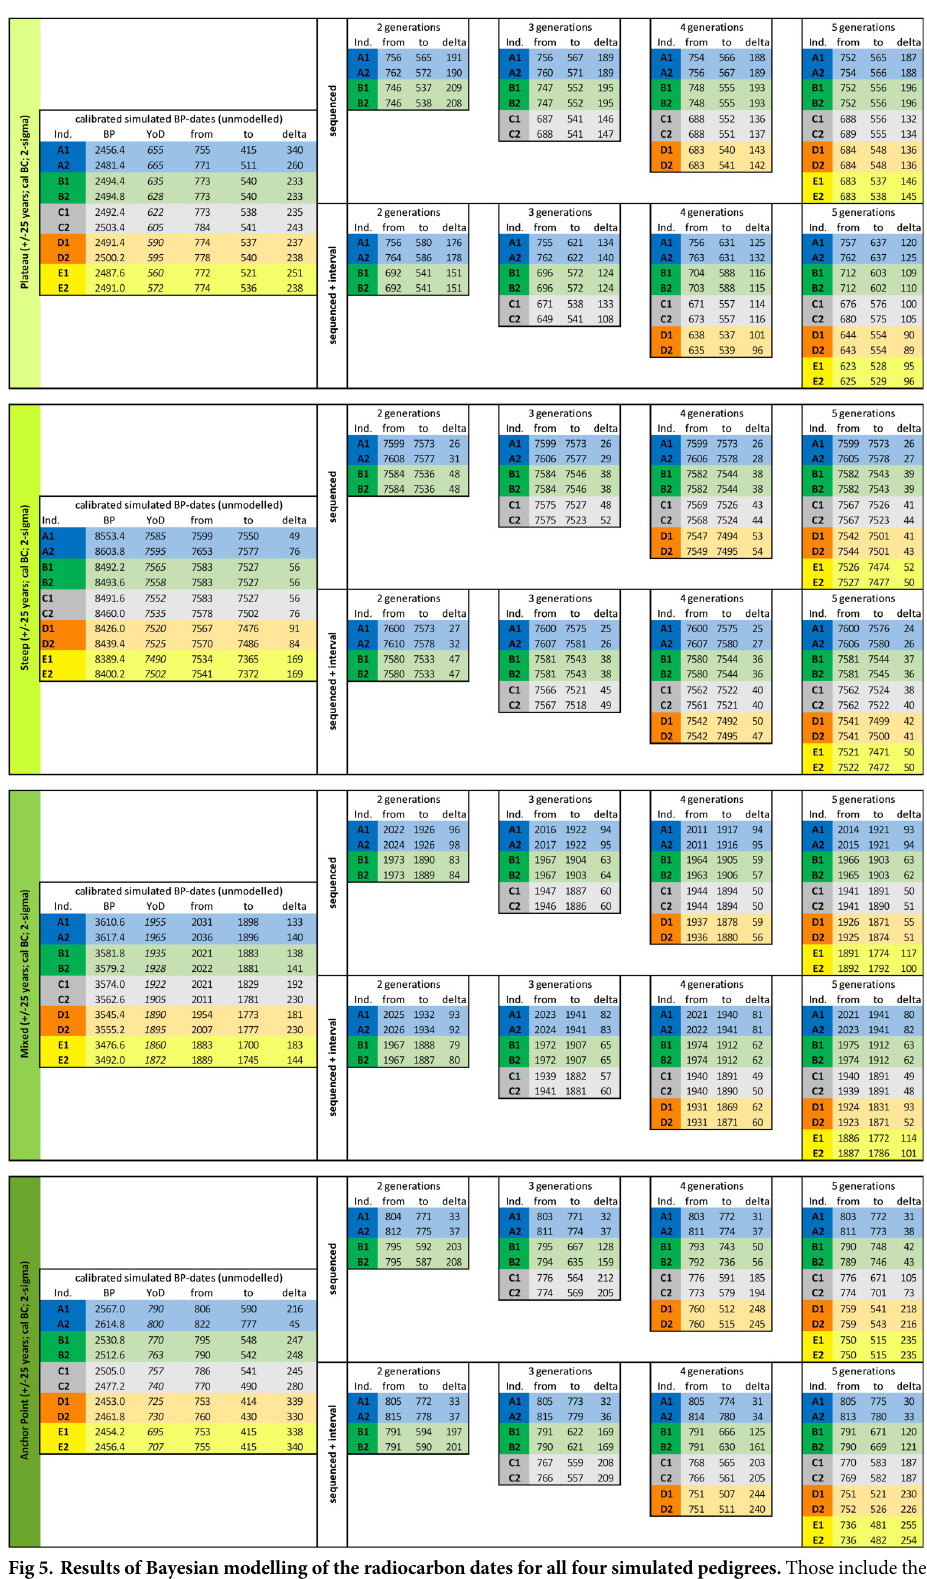
Fig 5. Results of Bayesian modelling of the radiocarbon dates for all four simulated pedigrees. Those include the unmodelled radiocarbon dates for each individual and their 2-sigma dating ranges as well as all results of runs with and without intervals between generations divided according to the varying number of